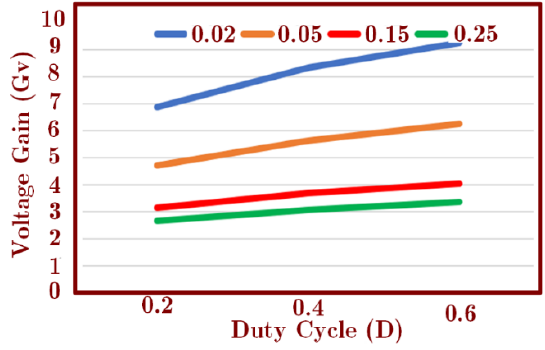
Figure 6. DCM analysis voltage gain vs. duty cycle.